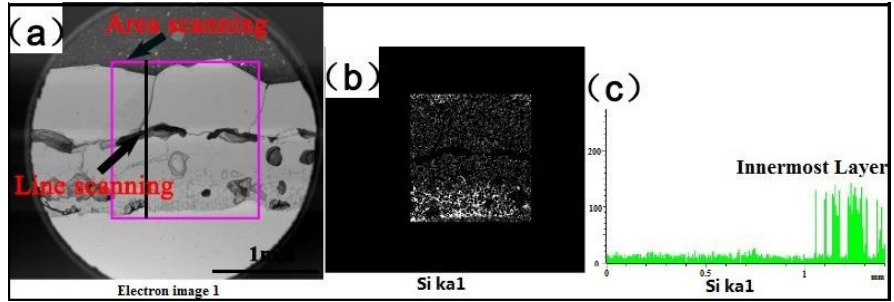
Figure 7. The results of Si distribution in inner scale by line scanning and area scanning. ( a ) The morphology micrographs of oxide scale; ( b ) the results of area scanning; ( c ) the results of line scanning.